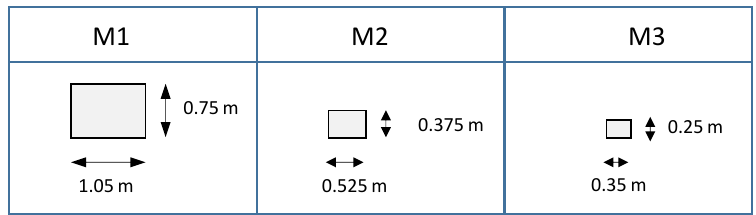
Figure 9. Block sizes (front views) for the sensitivity analysis.